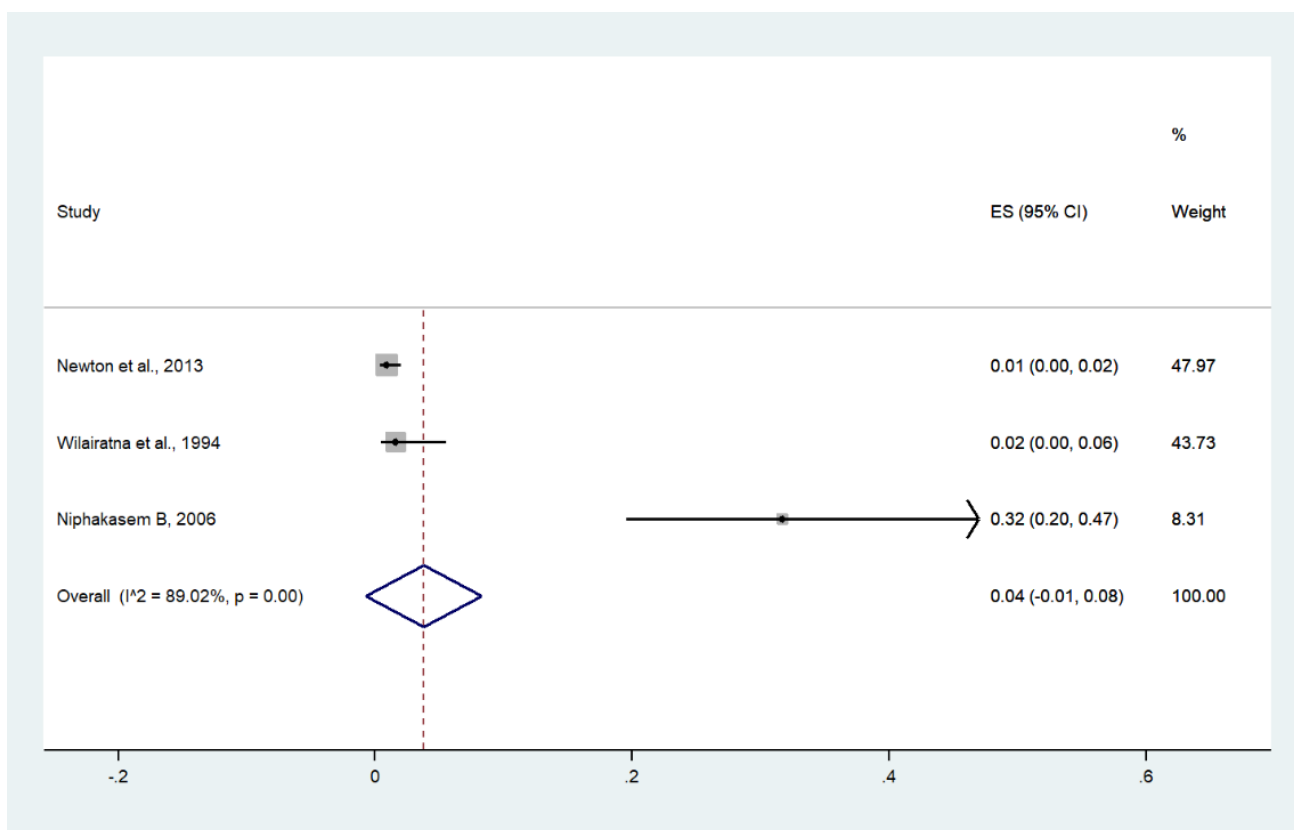
Figure 17. The pooled prevalence of hypoglycemia among patients with severe malaria in Thailand. The label for the x-axis is the scale of estimated prevalence. Abbreviations; ES, estimated prevalence; CI, confidence interval .